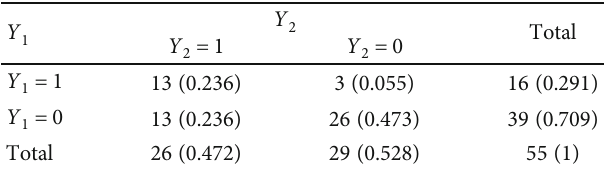
Table 2: The observed frequencies and proportion of the dependent variables.